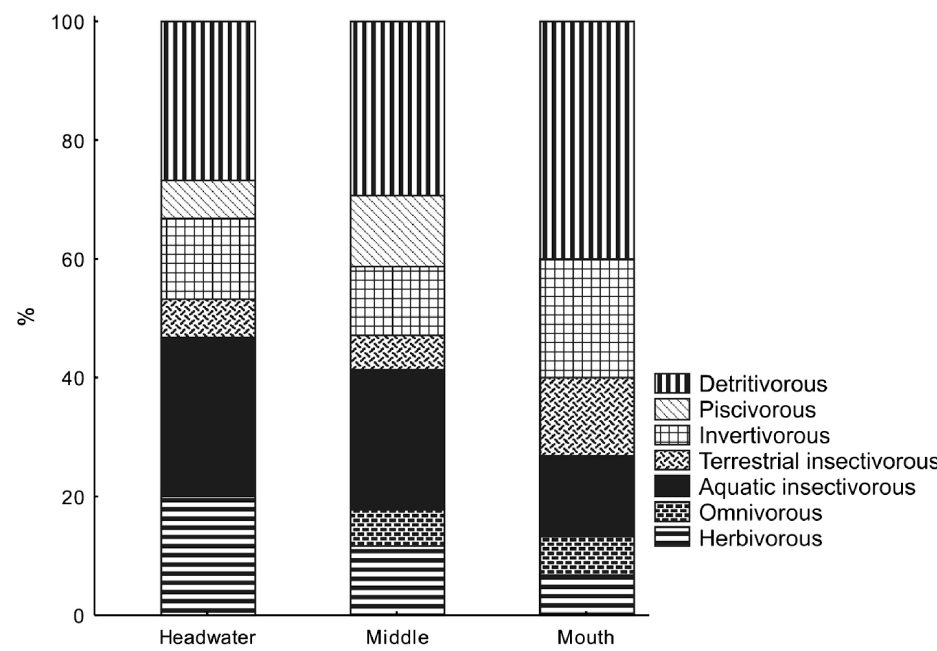
Figure 2. Relative frequency of the species richness according to trophic guild along the longitudinal gradient Itiz